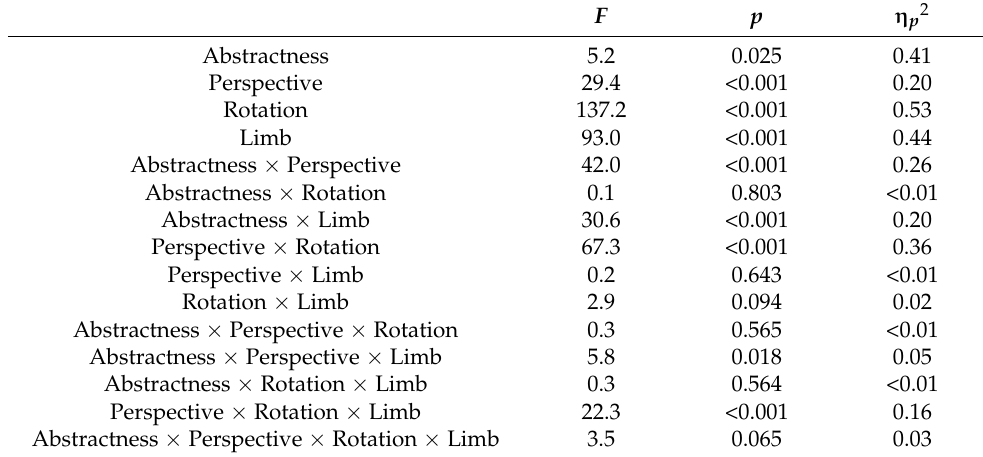
Figure 4. Boxplots of the linear integrated speed-accuracy scores (LISAS) depending on perspective (front view, back view), rotation (head-up, head-down), abstractness (realistic, abstract), and limb (arm, leg) in Study 2. Table 1. Statistical values of the ANOVA ( df 1 = 1, df 2 = 121) on LISAS in Study 2. F p η p